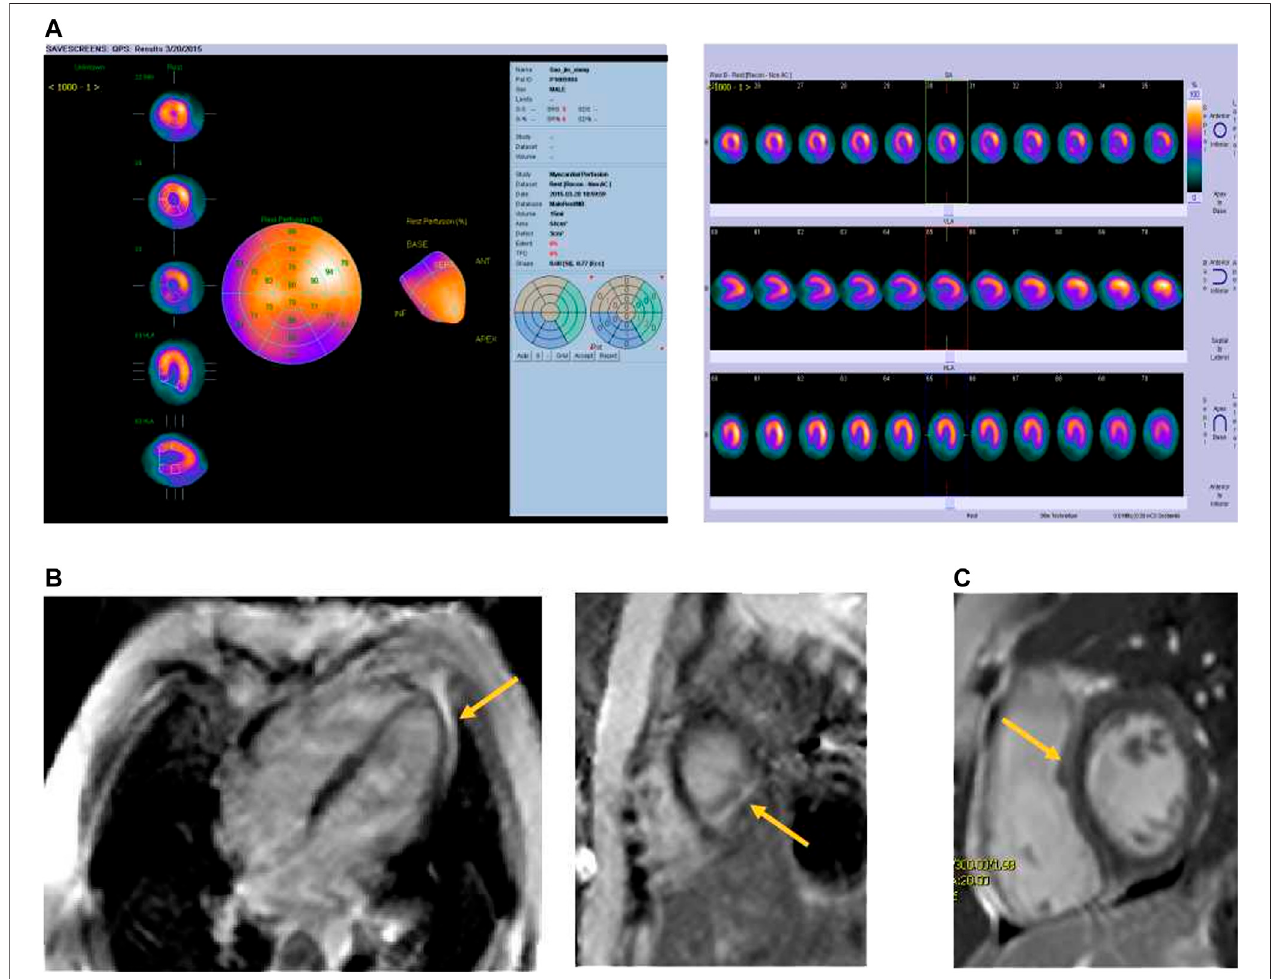
FIGURE 4 | The images of cardiac disorders of ALL patients. (A) Cardiac ECT showed myocardial ischaemia, a signi fi cant decrease in blood perfusion in the posterior left ventricular wall; (B) Cardiac Late Gd imaging in horizontal long-axis and short axis demonstrated myocardial enhancement in the inferior left ventricular wall and apex; (C) Cardiac Late Gd imaging in short axis demonstrated a midwall enhancement on the ventricular septum.